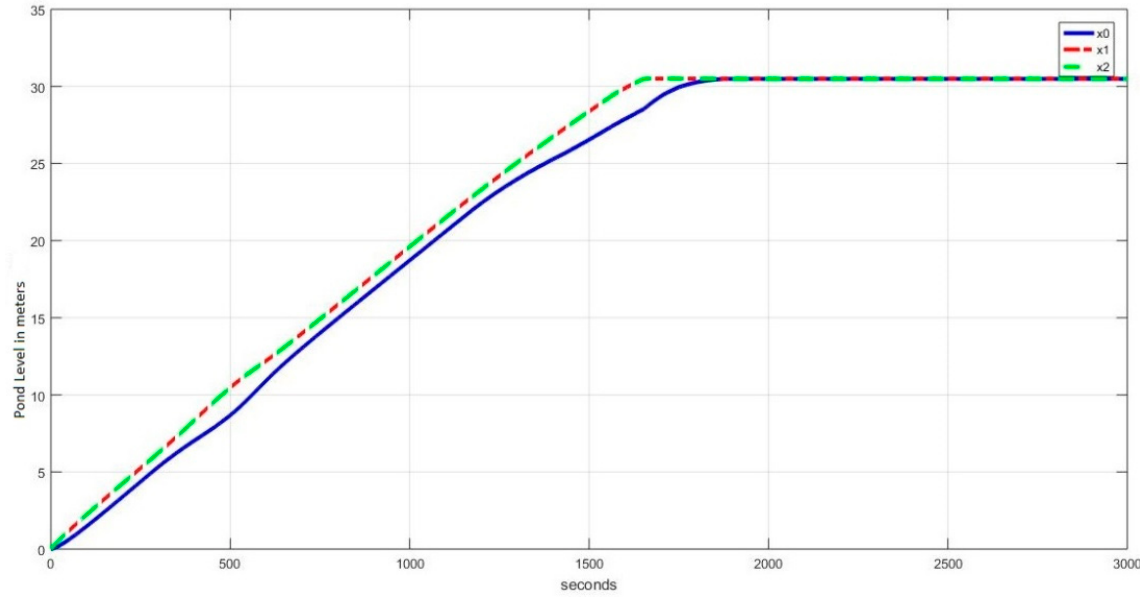
Figure 6. Desired water levels vs. time. T 0 , T 1, and T 2 at 30 m.